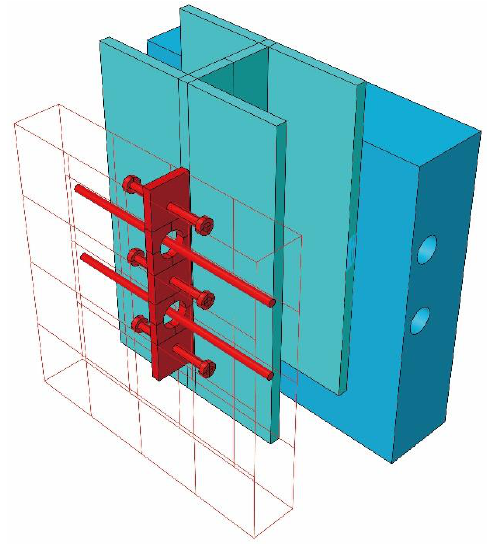
Figure 14. Finite element model.